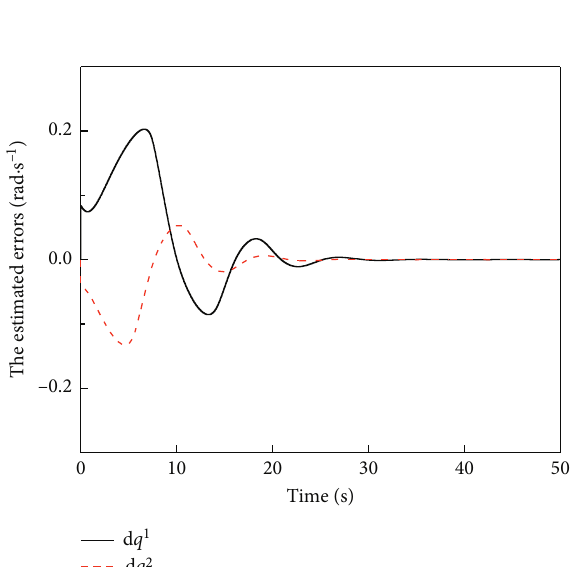
Figure 17: The control torque (Nm).